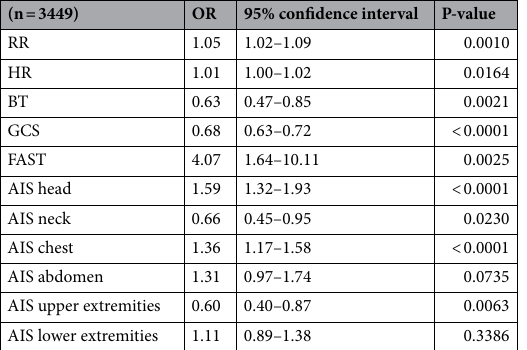
Table 5. Multivariate analysis results of factors associated with adult outcomes (26–45 years). AIS abbreviated injury scale, BT body temperature, CI confidence interval, FAST focused assessment with sonography for trauma, GCS Glasgow Coma Scale, HR heart rate, OR odds ratio, RR respiratory rate. Logistic regression analyses.